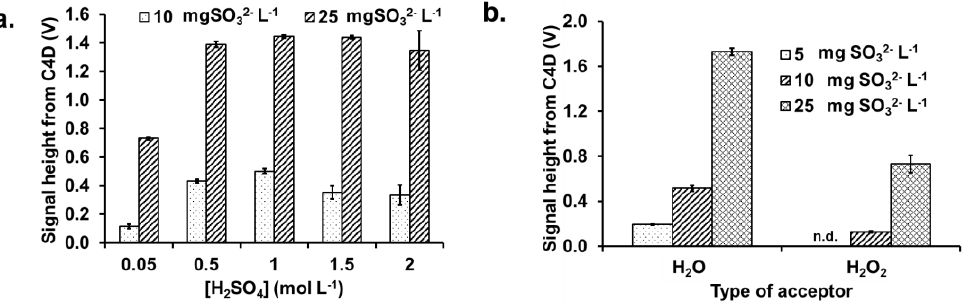
Figure 3. Bar graphs of the e ff ect of ( a ) sulfuric acid concentration in the donor stream and ( b ) the type Figure 3 . Bar graphs of the effect of ( a ) sulfuric acid concentration in the donor stream and ( b ) the of acceptor solution on C4D signal heights. n.d.: not type of acceptor solution on C4D signal heights. n.d.: not detected.